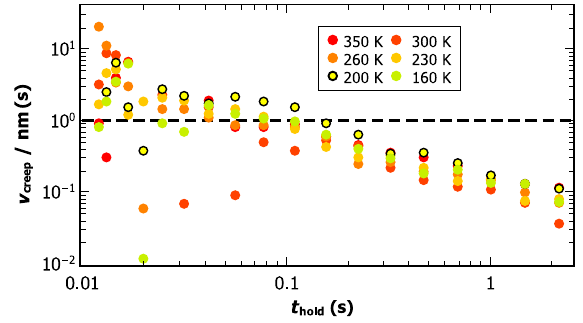
FIG. 4. Temperature-dependent creep velocities v function of the hold time t slide-hold-slide